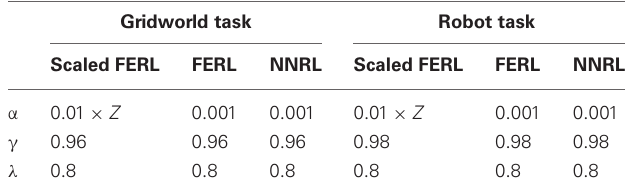
Table 1 | Meta-parameter settings for the experiments.